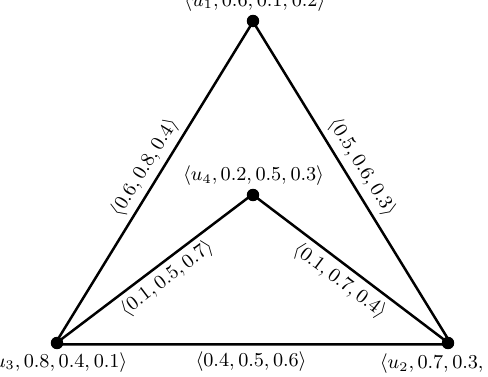
Figure 11. Single-valued neutrosophic graph Figure 11: SVNG